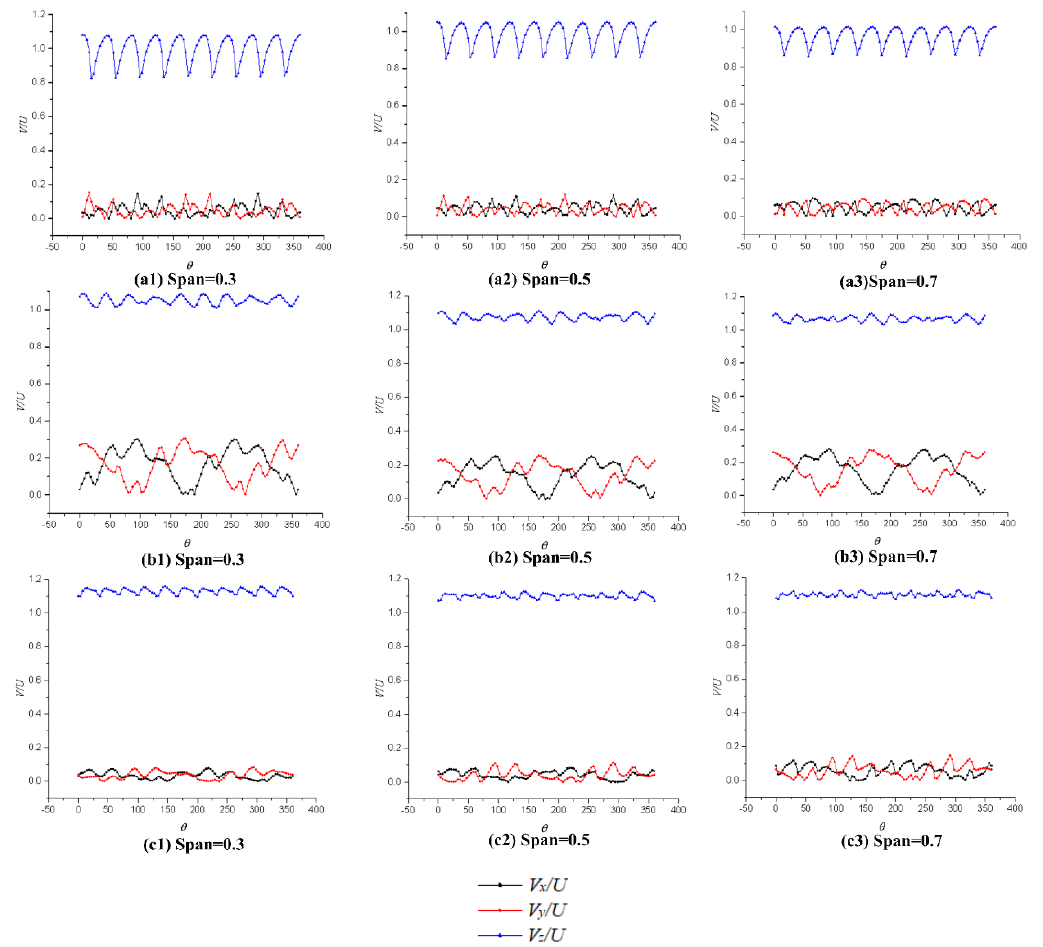
Figure 29. Velocity distribution of pump-jet after optimization (a1, a2, a3 are rotor inlet, b1, b2, b3 are between rotor and stator, c1, c2, c3 are stator outlet).